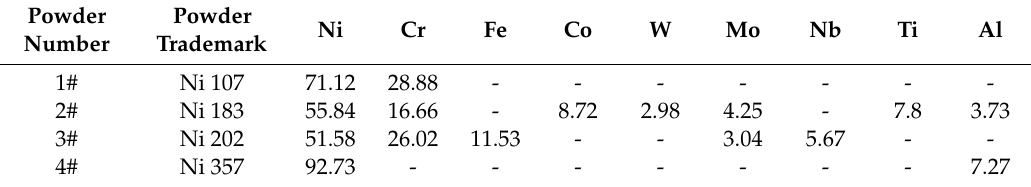
Figure 1. Morphology and energy dispersive spectrometry (EDS) results of Ni-based alloy powders. Table 1. Composition of elements in four kinds of Ni-based alloy powders (wt.%). Table 2. Chemical component of AISI 4140 steel (wt.%).